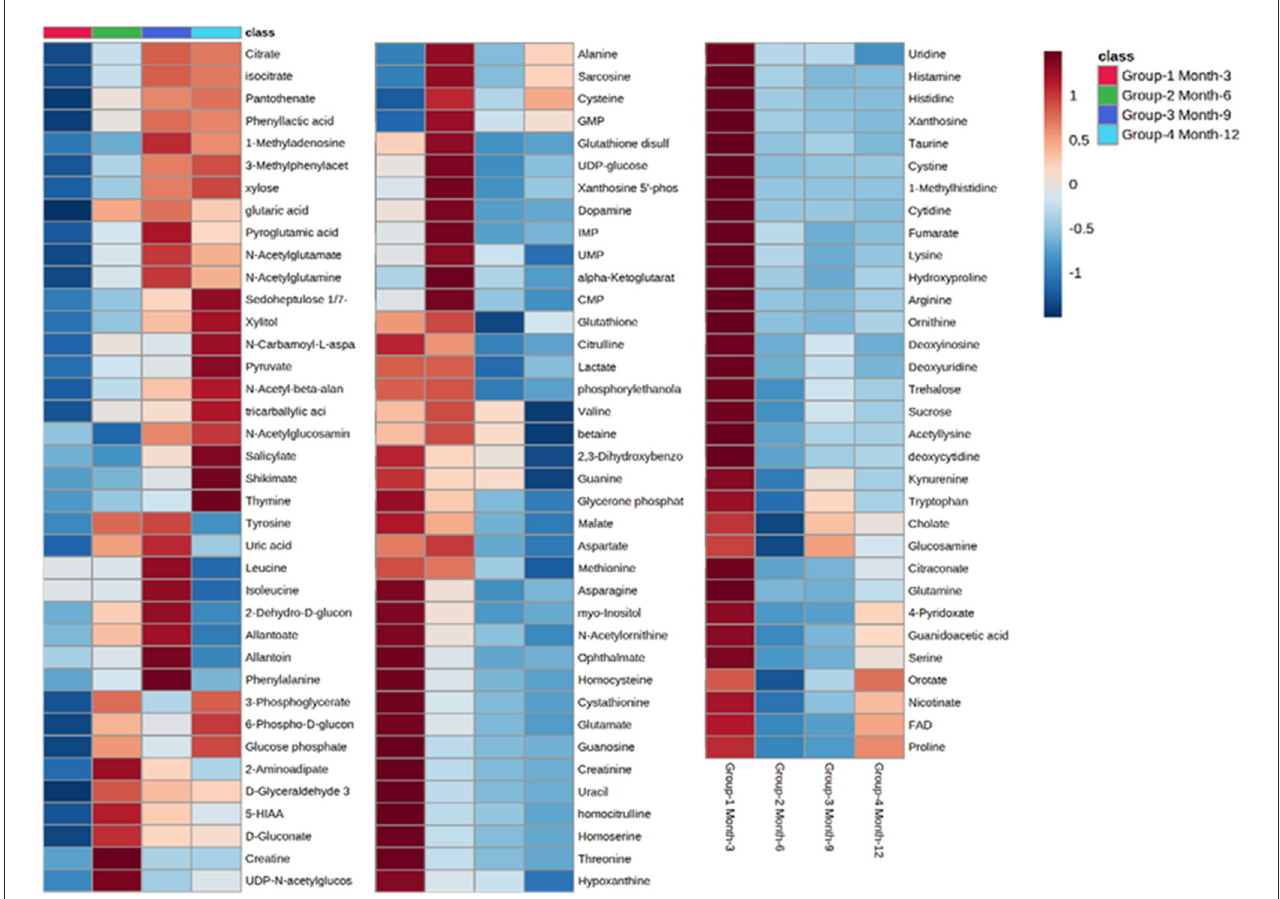
FIGURE8 Heatmap illustrating abundance profile fluctuations in detected metabolites over study time points. From left to right, columns denote 3, 6, 9, and 12-month time points, with each row representing a detected